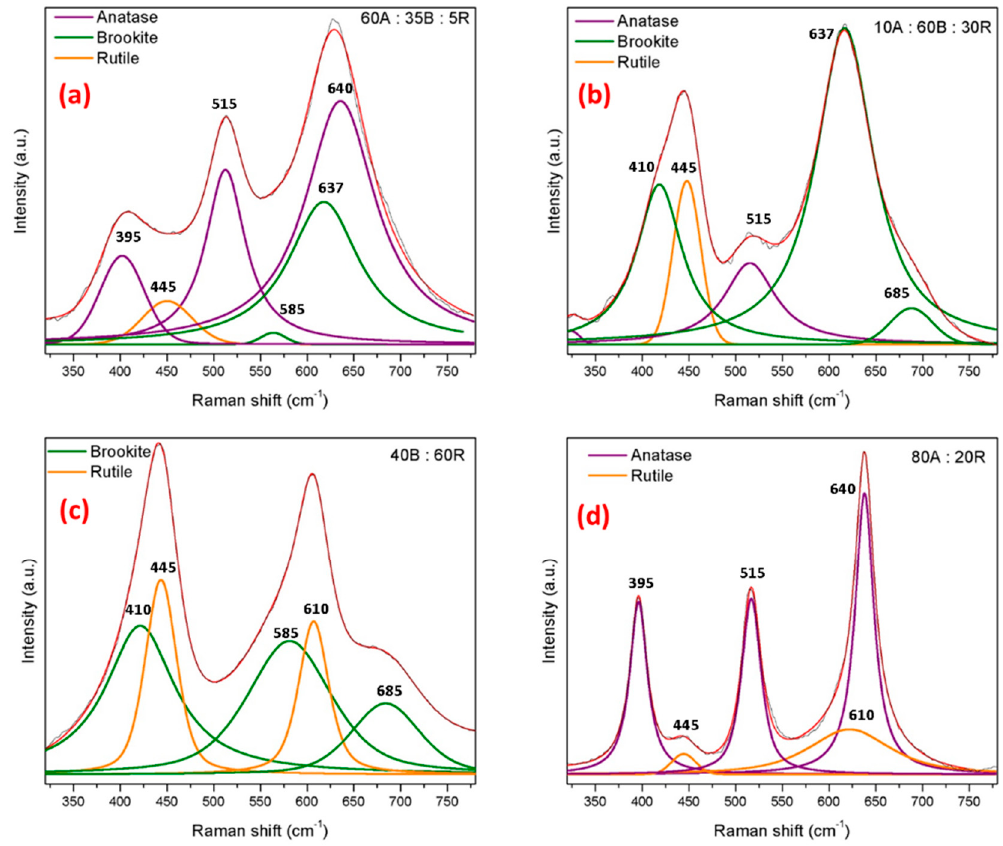
Figure 2. Raman spectra of synthesized mixed-phase nanoTiO 2 photocatalysts; ( a ) anatase major, A / b , ( b ) brookite major, B / r ( c ) rutile major phase R / b and ( d ) commercial P25.